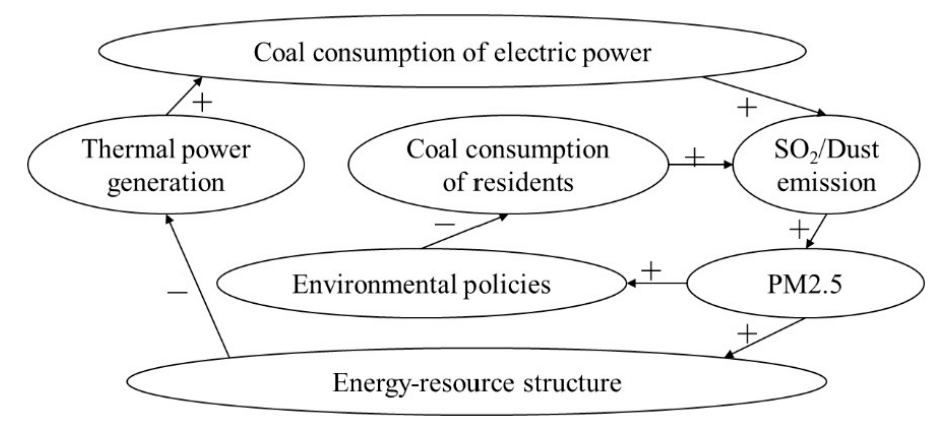
Figure 5. Causality diagram of Beijing coal consumption system.